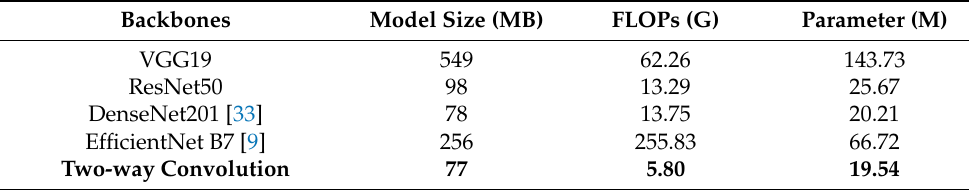
Table 4. Model size, FLOPs, and number of parameters of backbones.